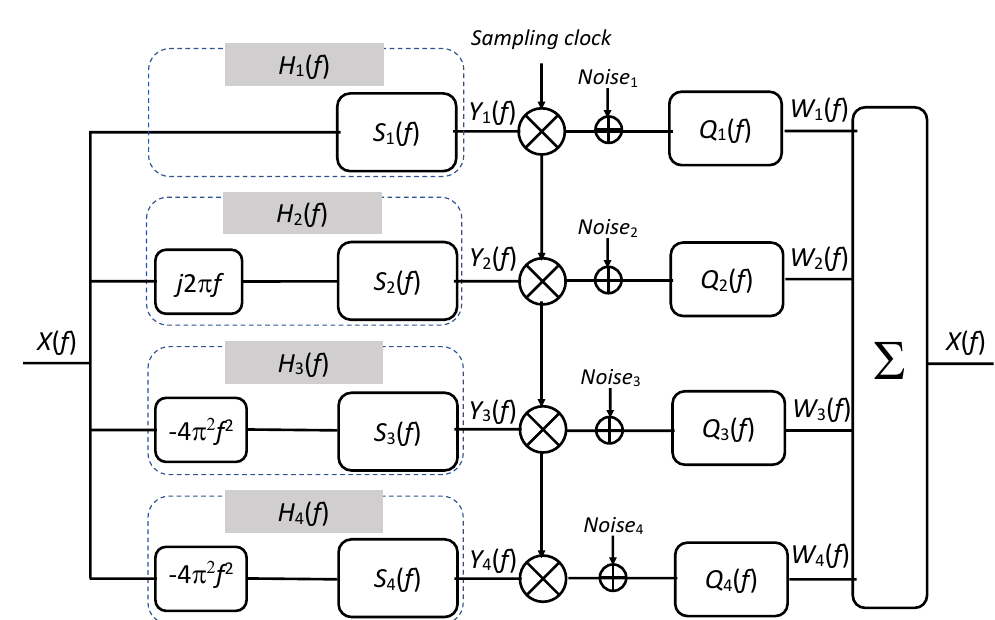
Figure 1. Diagram of a multi-channel system with 4 sensors. The input quantity is a position signal, and there are a velocity sensor and 2 acceleration sensors, characterized in terms of their frequency responses S l ( f ) . The operators j 2 π f and − 4 π 2 f 2 stand at the front-end of the velocity and acceleration sensors to transform the position input into velocity and acceleration signals. The common input is X ( f ) and represents the spectrum of a position signal; each channel is described in terms of a frequency response H l ( f ) . The outputs of the sensors are sampled and degraded by (quantization) noise before entering the filters Q l ( f ) required to combine the outputs of the individual